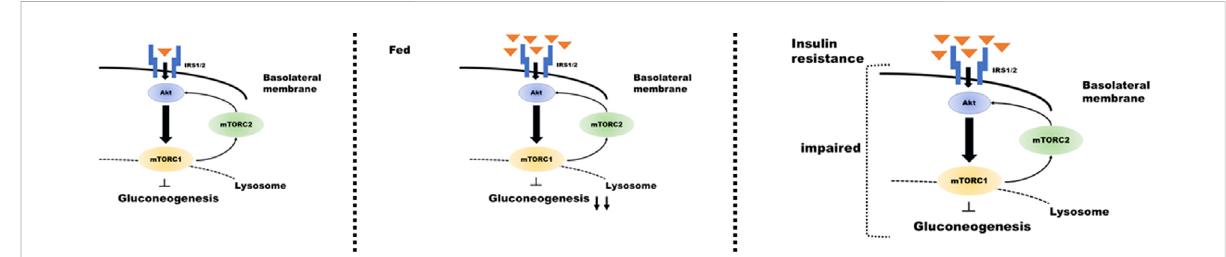
FIGURE 2 Regulation of insulin signaling in the proximal tubule during gluconeogenesis under different conditions. Proximal tubular gluconeogenesis respondsdifferentlydependingonthestateofinsulinsecretionandthepresenceofinsulinresistance.Wheninsulinissecretedafterconsumingfood (center panel of the fi gure), insulin/mTOR signaling is enhanced, and gluconeogenesis is inhibited. The condition of insulin resistance (right panel) results in impaired insulin/mTOR signaling and enhanced gluconeogenesis despite high blood glucose